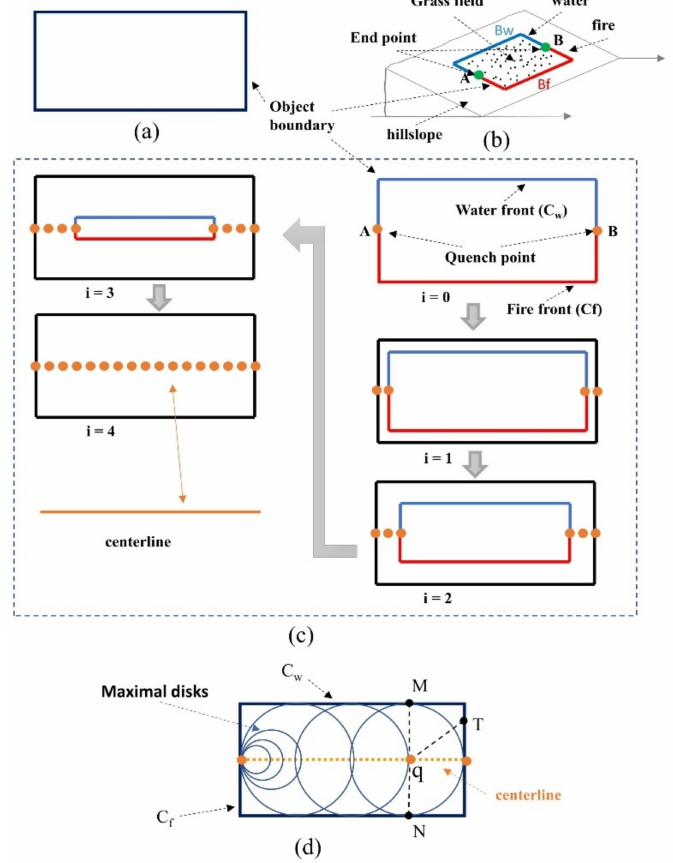
Figure 4. Schematic illustration of fire extinguishing process on a rectangular polygon; ( a ) rectangular polygon; ( b ) schematic of the dry grass field in a slope, the dry grass field represent the object; ( c ) schematic of fire extinguishing process; ( d ) schematic of centerline skeleton by medial axis